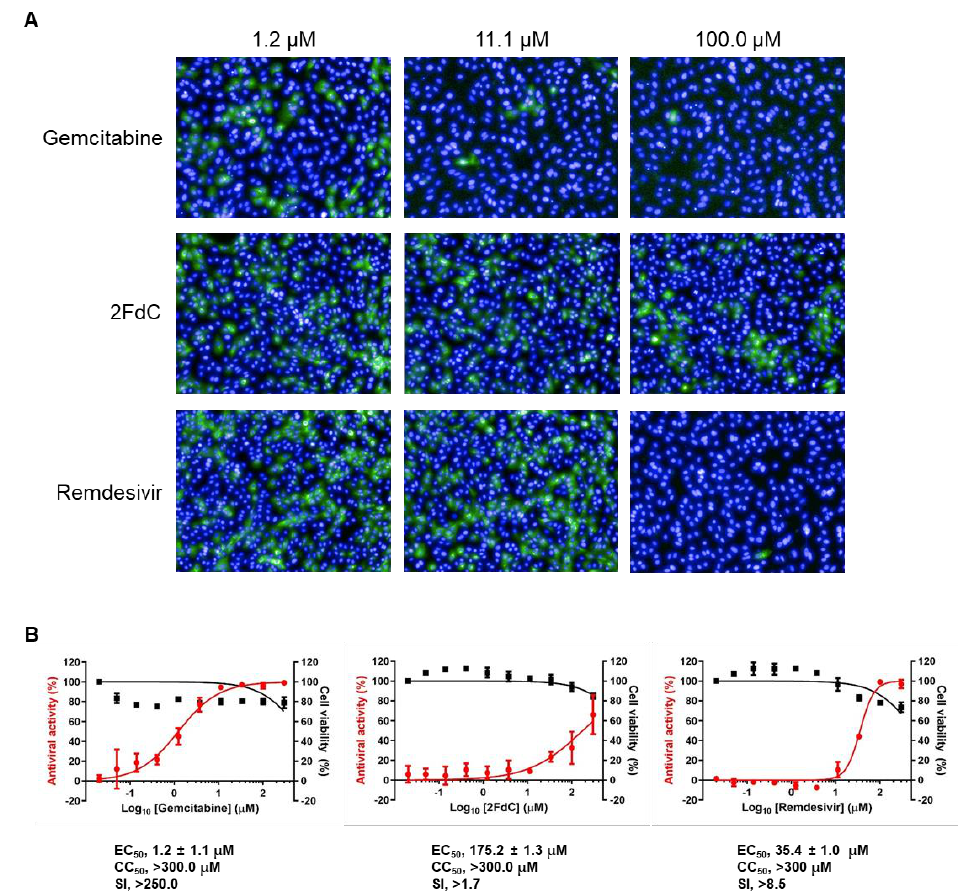
Figure 2. Evaluation of the antiviral activity of gemcitabine, 2FdC, and remdesivir against SARS-CoV-2 in a fluorescence image-based antiviral assay system. ( A ) Visualization of decrease in viral S protein level in the presence of the antiviral compounds. Vero cells were treated with 3-fold serial dilutions of each compound (300 to 0.02 μM over 10 concentrations) for 30 min. Cells were infected with SARS-CoV-2 at an MOI of 0.02. At 24 h post-infection, viral S protein (green) and nuclei (blue) were visualized by fluorescence microscopy. Representative images are shown from eight images per sample at compound concentrations of 1.2, 11.1, and 100.0 μM. Magnification ×20. ( B ) Antiviral activity (left y-axis, red circles) and cell viability (right y-axis, black squares) at increasing concentrations of gemcitabine (left panel), 2FdC (middle panel), and remdesivir (right panel). Percentage means and standard deviations are calculated from four different spots per sam- ple in triplicate. EC 50 and CC 50 values were determined from a nonlinear regression equation and are shown below each panel. Selectivity index (SI), ratio of CC 50 to EC 50 .